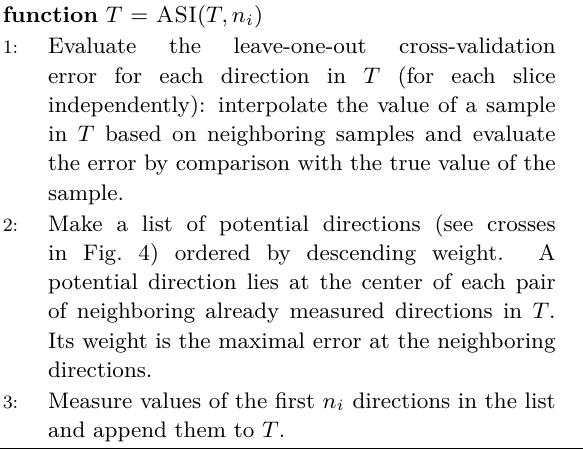
Algorithm 2 Adaptive sampling iteration